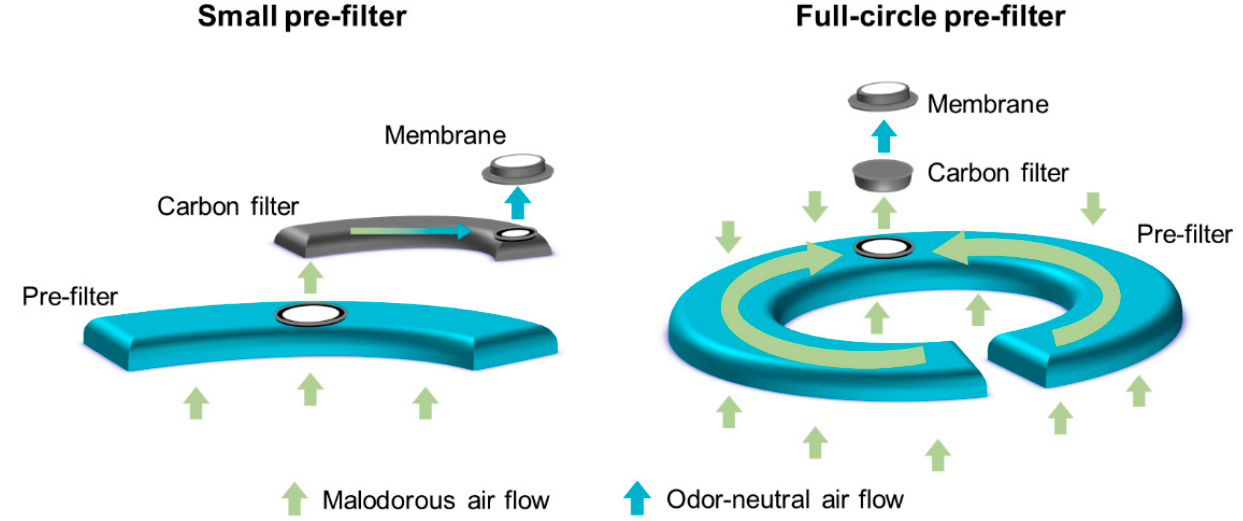
Figure 2. Schematic of the small pre-filter (used in the dual filter system) and the full-circle pre- filter.